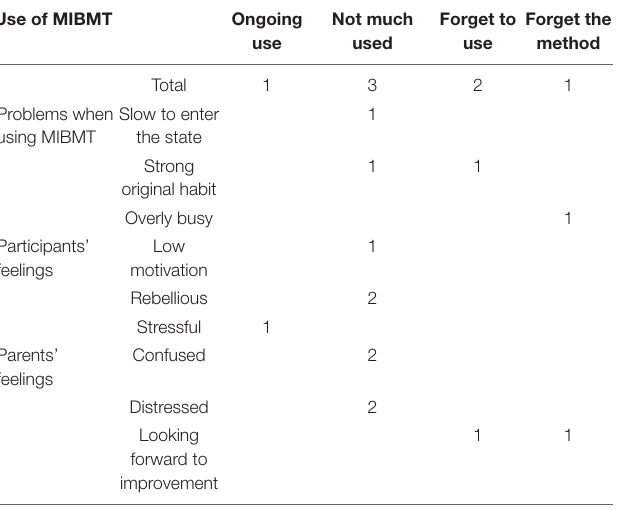
TABLE 18 | Theme 2: negative feedbacks after training in Experiment 2. Use of MIBMT